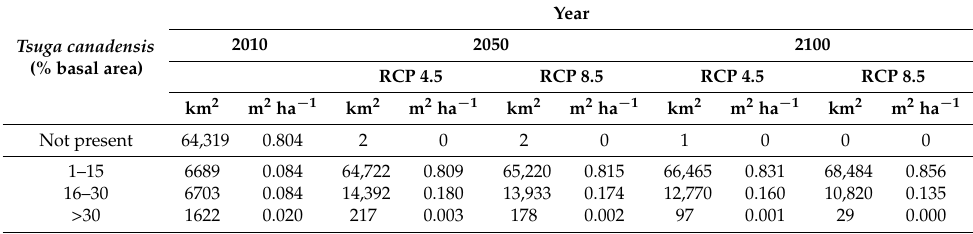
Table 1. Tsuga canadensi s abundance as a measure of % total stand basal area across the state of Maine using current estimates (2010) provided by Dunckel et al., 2015, with predictions under RCP 4.5 (2050, 2100) and RCP 8.5 (2050,